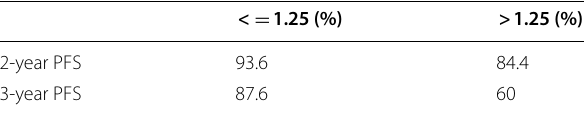
Table 10 Progression‑free survival in children with rDS above and below the cutoff value